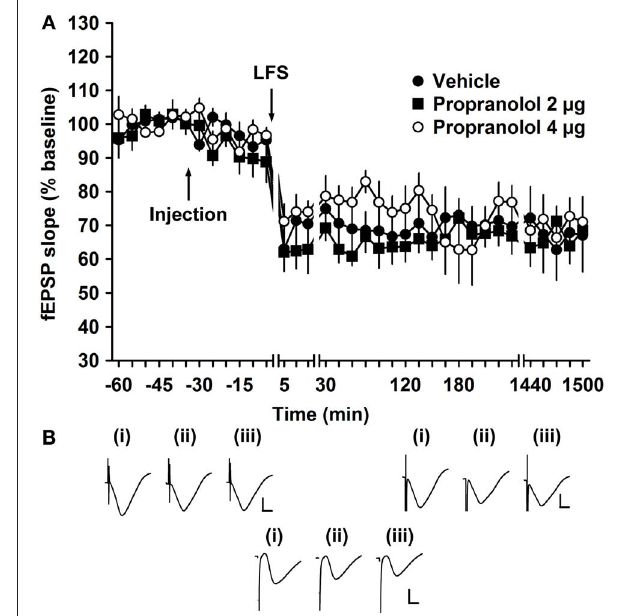
FIGURE 5 | β -adrenergic receptor antagonism has no effect on electrically induced long-term depression of mossy fiber synapses. (A) Injection of the β -adrenergic receptor antagonist, propranolol (2 μ g), has no significant effect on the profile of electrically induced LTD (elicited by low frequency stimulation, LFS, of 900 pulses at 1Hz) compared to vehicle-injection. Line breaks indicate changes in time scale. (B) Analogs represent fEPSP responses obtained (i) 5min pre-LFS, (ii) 5min post-LFS, and (iii) 24h post-LFS in the presence of vehicle ( left upper panel ), in the presence of a low dose (2 μ g) of propranolol ( right upper panel ) or a high dose (4 μ g) of propranolol ( lower panel ). Vertical scale bar: 2mV, horizontal scale bar: